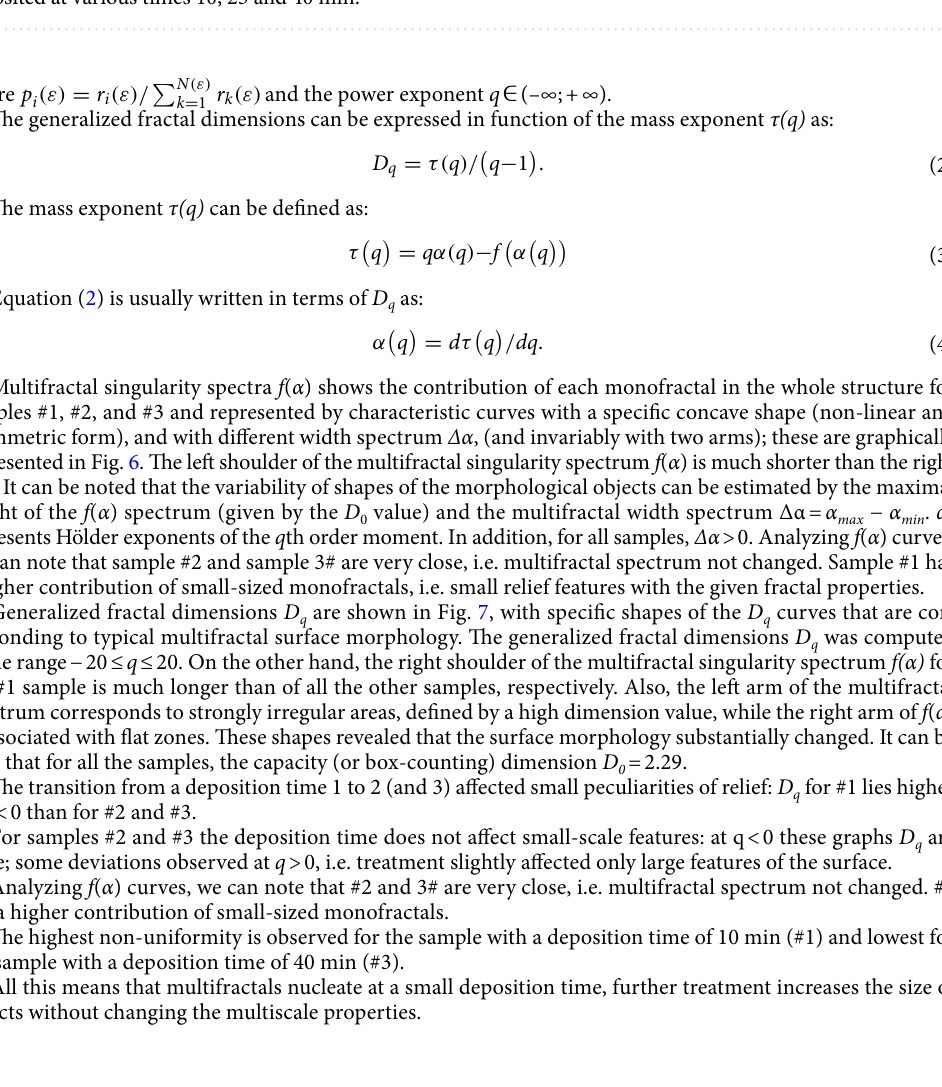
Figure 6. The graphical representation of the multifractal singularity spectra f(α) of samples #1, #2 and #3 deposited at various times 10, 25 and 40